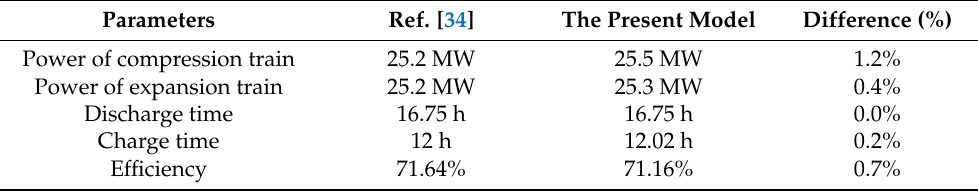
Table 6. The comparison of the A-CAES model results from the present model and Ref.